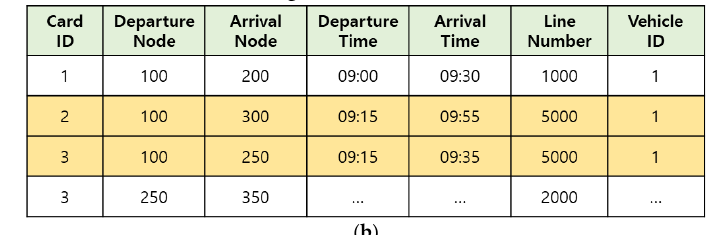
Figure 4. Example of optimal route allocation after adding a new line: ( a ) before; ( b ) after.